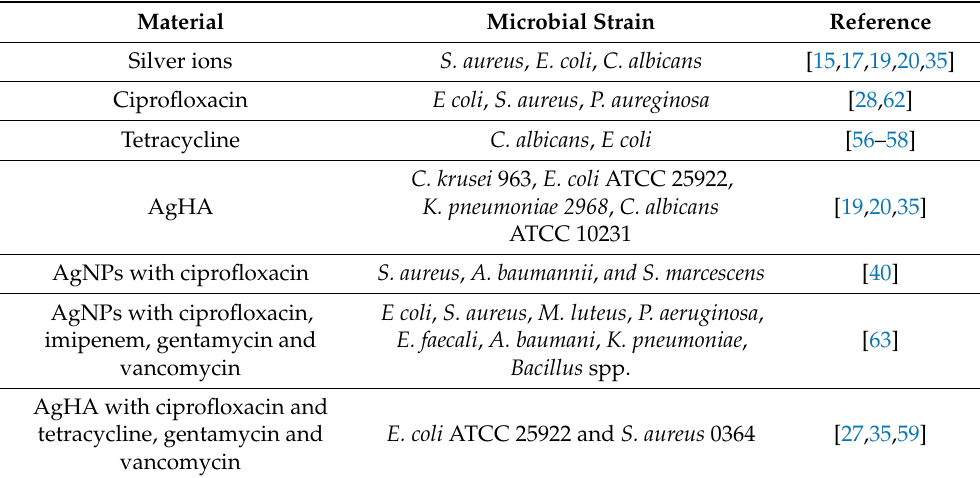
Table 2. Combined and individual efficacy of tetracycline and ciprofloxacin antibiotics, AgNPs and AgHA against selected microbial